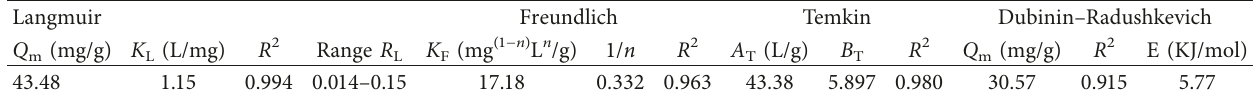
Table 8: Comparison of the obtained adsorption capacity with the previously developed adsorbents in the literature. Adsorbents